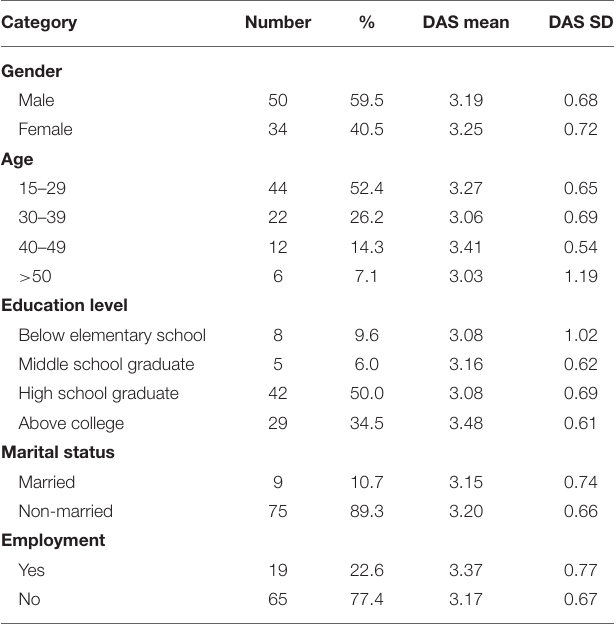
TABLE 1 | General characteristics of the study subjects ( n =